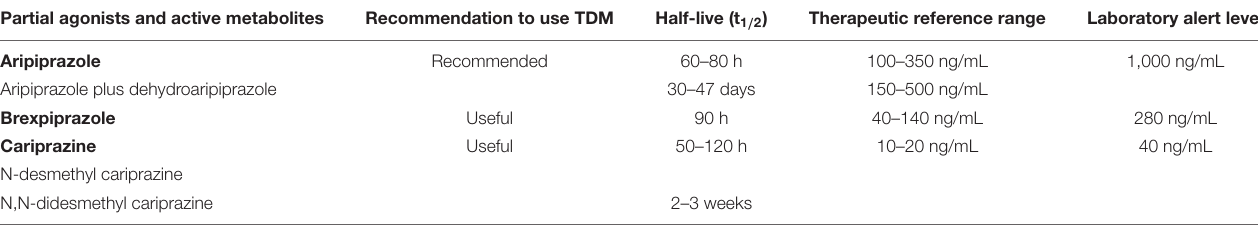
TABLE 4 | Main pharmacokinetic parameters derived from PET studies of aripiprazole, brexpiprazole and cariprazine. Partial agonists and active